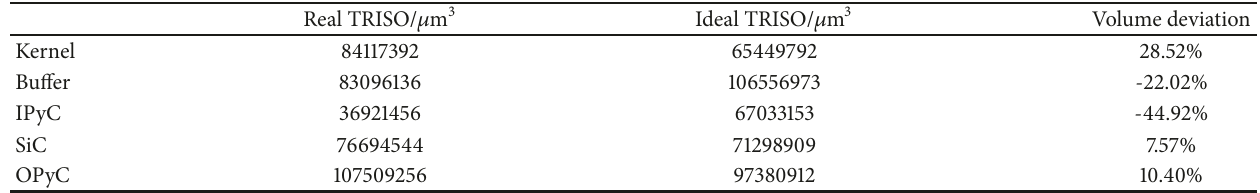
Table 2: Measured volume for the TRISO